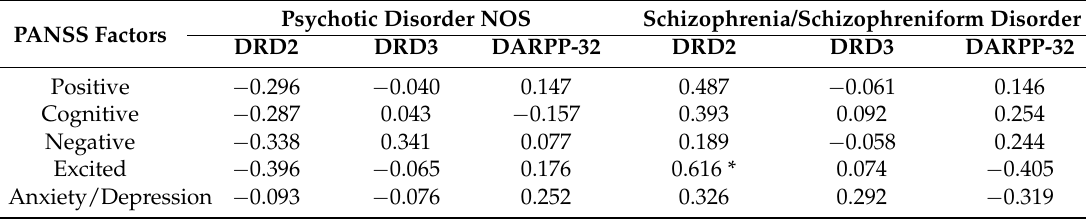
Table 4. Spearman rank correlations analysis between DRD2 , DRD3 , and DARPP-32 mRNA levels and five factors of the PANSS in patients with psychotic disorder NOS and the schizophrenia/ schizophreniform disorder